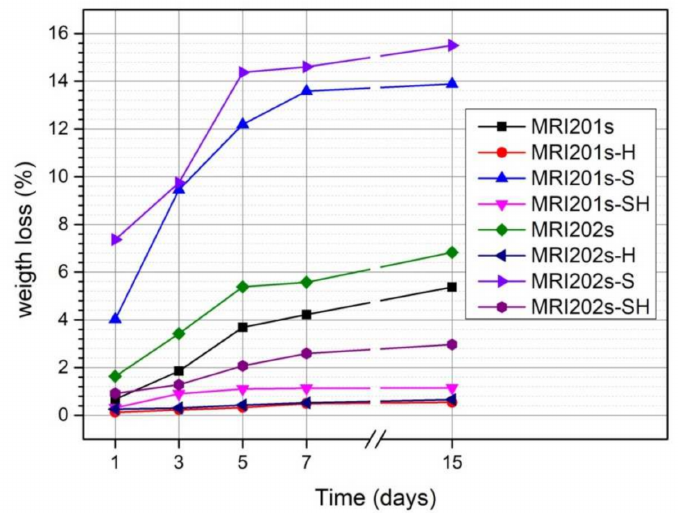
Figure 9. Weight loss of untreated and treated MRI201s and MRI202s samples after 1, 3, 5, 7 and 14 days of immersion in NaCl